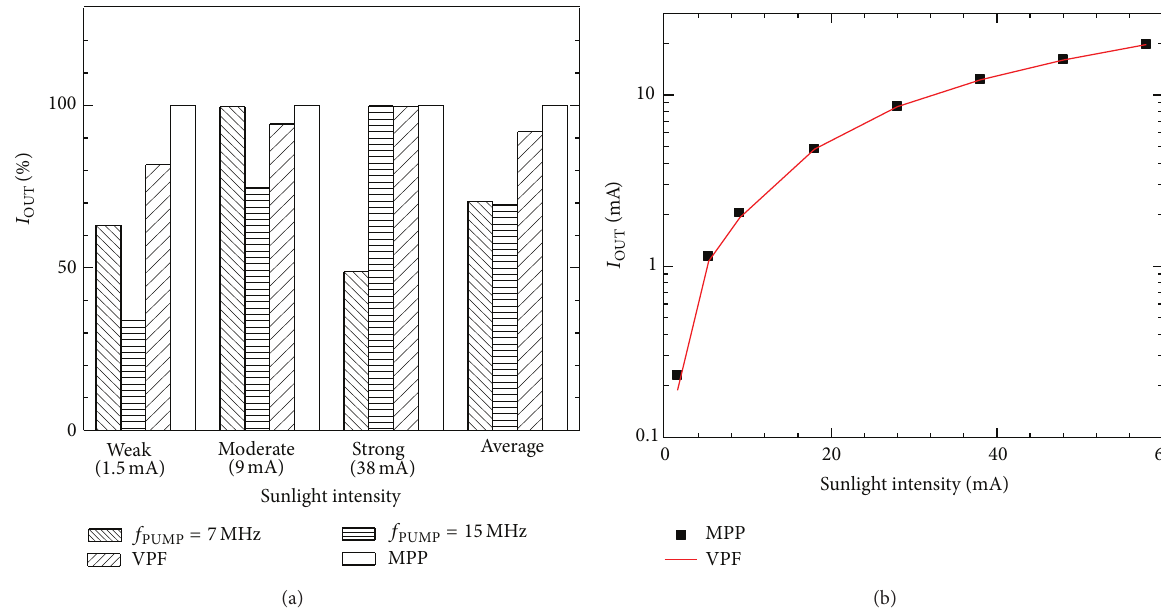
Figure 7: (a) The percentage 𝐼 for various sunlight conditions with the fixed pumping frequencies of 7 MHz and 15MHz and the VPF OUT scheme. Here MPP means the simulated maximum output currents. (b) The output current comparison between the proposed VPF scheme and the simulated maximum output currents (MPP).